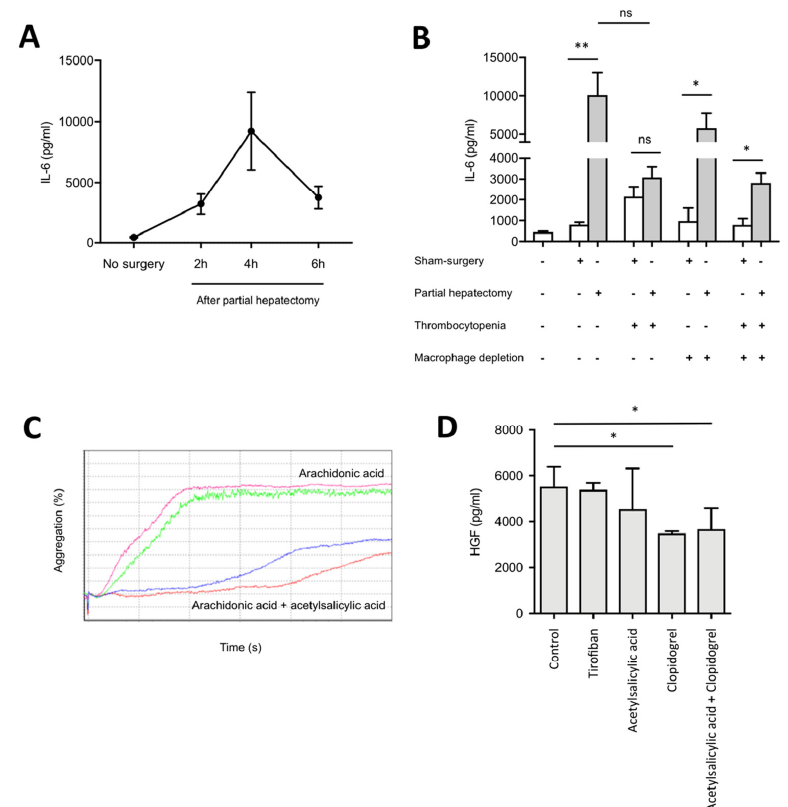
( D ) E ff ects of anti-aggregant drugs on HGF levels in mouse serum at 48 h following partial hepatectomy. N = 3–4. * p < 0.05, ** p <